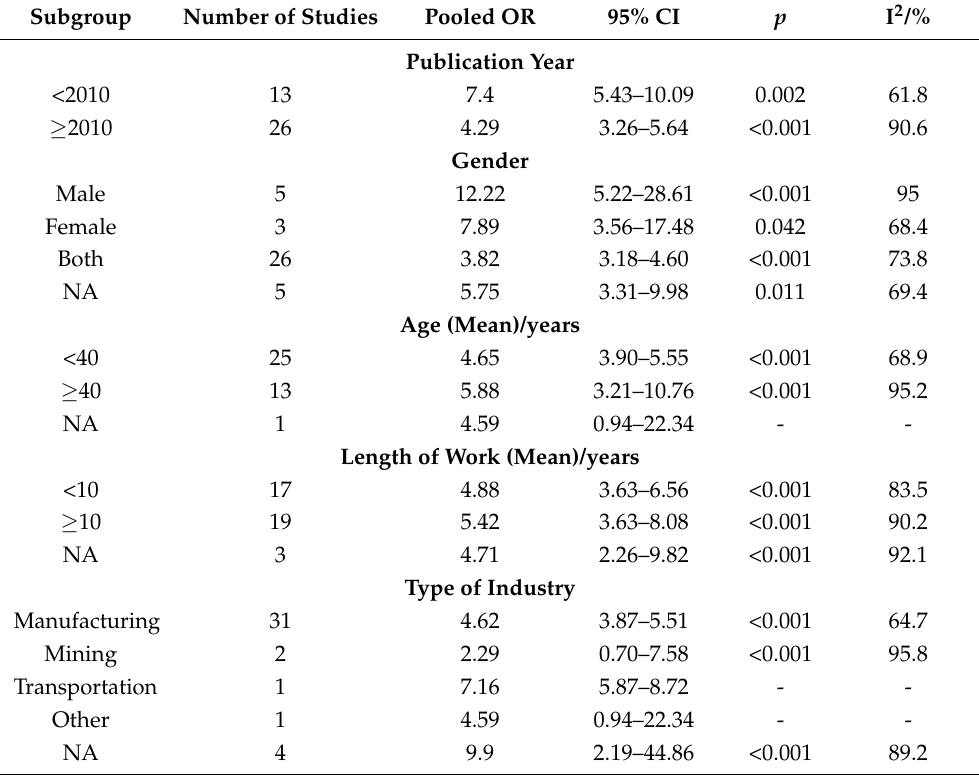
Table 3. Subgroup analysis of noise exposure and risk of